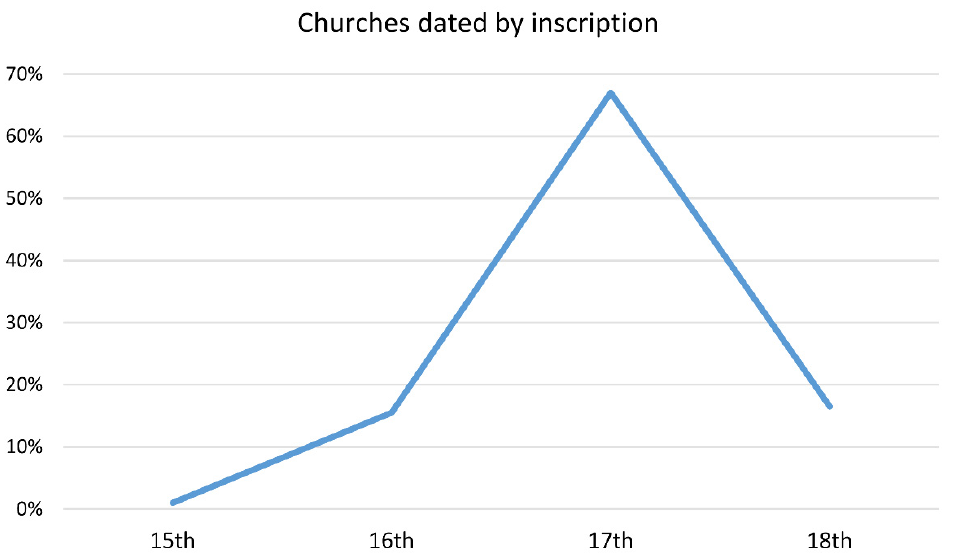
Figure 4. Ninety monastic, town and country/rural churches on the island of Paros, dated by their surviving inscriptions (data and graph by the author).